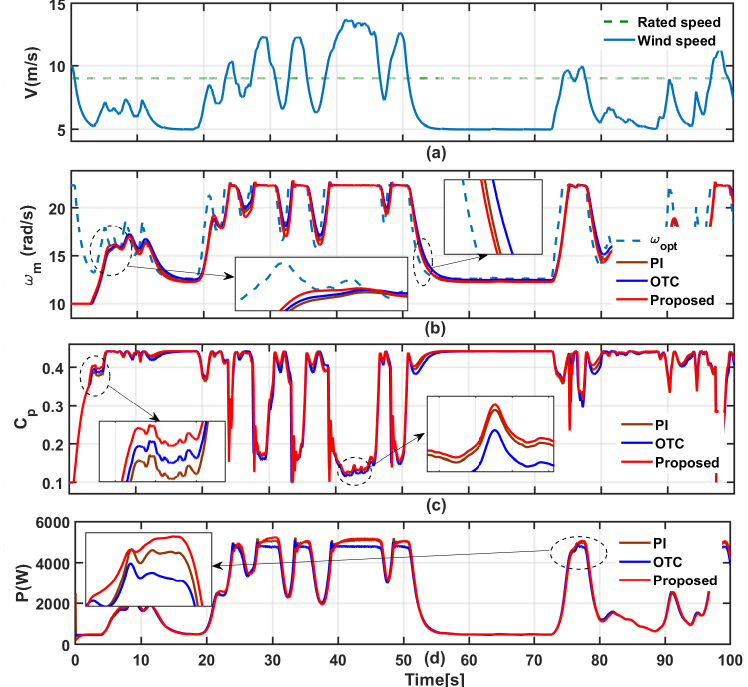
Figure 14. Results for the case III with real wind speed: ( a ) Real wind speed. ( b ) Rotor speed. ( c ) Power coefficient. ( d ) Output